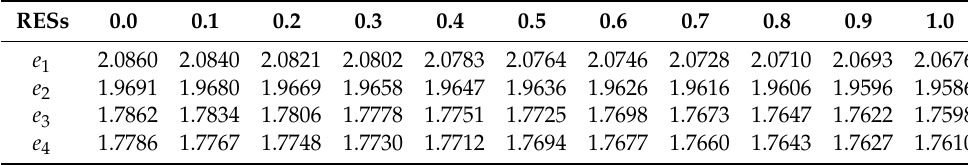
Table 15. Assessment values of RESs over different values of γ